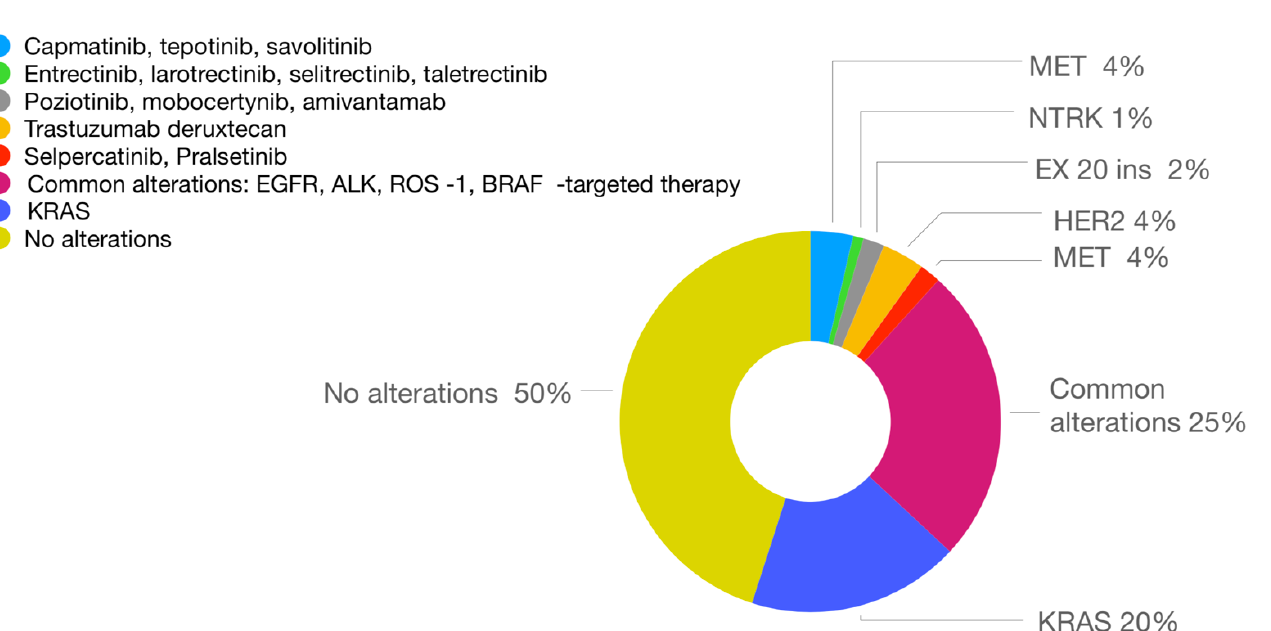
Figure 1. Frequency of genomic alterations in non-small-cell lung cancer (NSCLC) and corresponding targeted therapies.